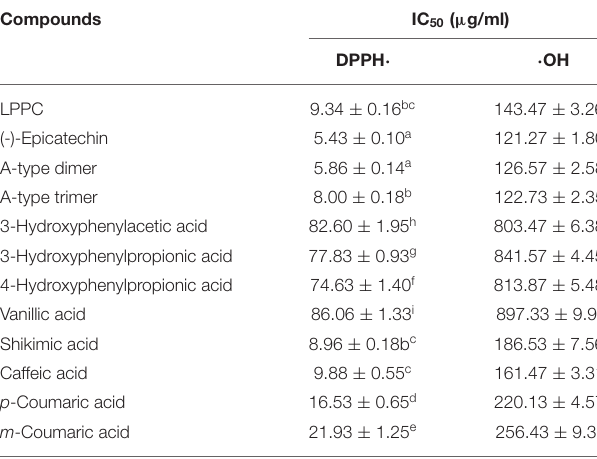
TABLE 3 | Antioxidant activity of LPPC and its metabolites in different assays.